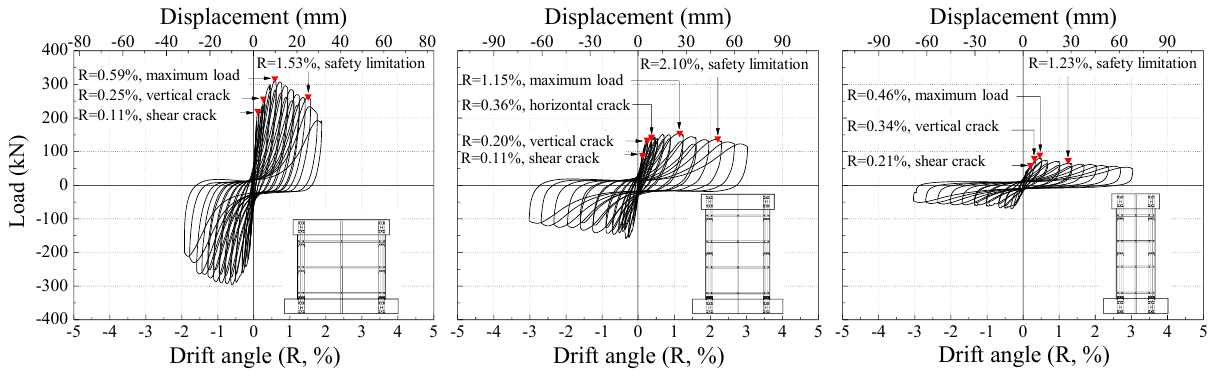
Figure 7. Lateral strength and drift angle relation.